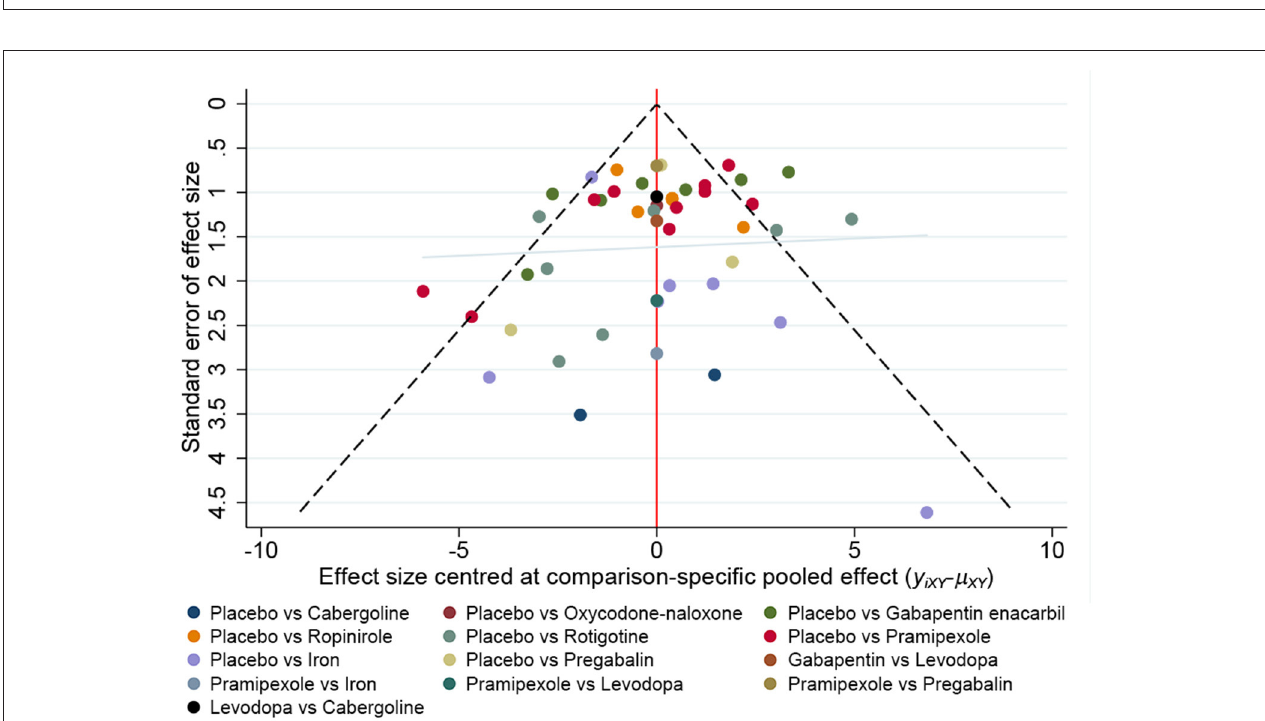
FIGURE 8 | The inconsistency plot for direct and indirect comparisons. (IF, inconsistent factor; CI, confidence interval).